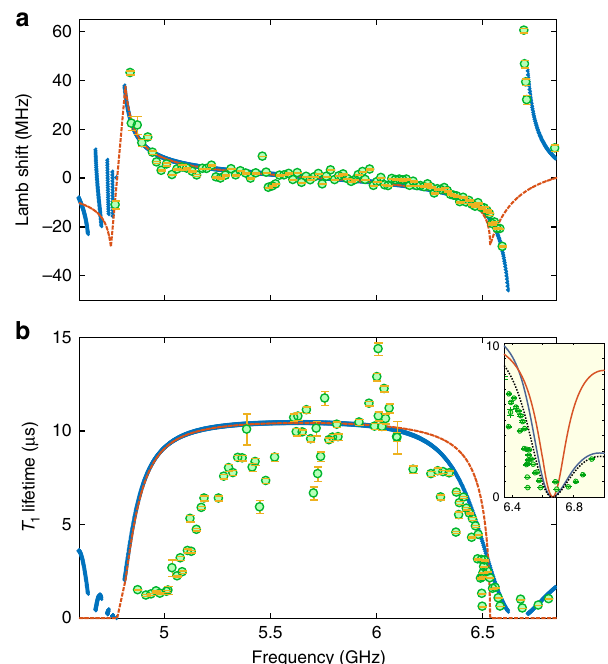
Fig. 3 Measured dispersive and dissipative qubit dynamics. a Lamb shift of the qubit transition vs. qubit frequency. b Lifetime of the excited qubit state vs. qubit frequency. Open circles show measured data. The solid blue line (dashed red line) is a theoretical curve from the circuit model of a fi nite (in fi nite) waveguide structure. For determining the Lamb shift from measurement, the bare qubit frequency is calculated as a function ffiffiffiffiffiffiffiffiffiffiffiffiffiffiffiffiffiffiffi q Φ ð Þ (cid:2) E of fl ux bias Φ as (cid:1) h ω ge ¼ 8 E E using the extracted values of E C , C J C E J , and assuming the symmetric SQUID fl ux bias relation E J ( Φ ) = E J, π Φ / Φ 22 . The lifetime characterization is performed in the time max cos(2 0 ) domain where the qubit is initially excited with a π pulse through the XY drive. The excited state population, determined from the state-dependent dispersive shift of a close-by band-edge waveguide mode, is measured subsequent to a delay time during which the qubit freely decays. Inset to ( b ) shows a zoomed in region of the qubit lifetime near the upper band- edge. Solid blue (red) lines show the circuit model contributions to output port radiation (structural waveguide loss), adjusted to include a frequency independent intrinsic qubit lifetime of 10.86 μ s. The black dashed line shows the cumulative theoretical